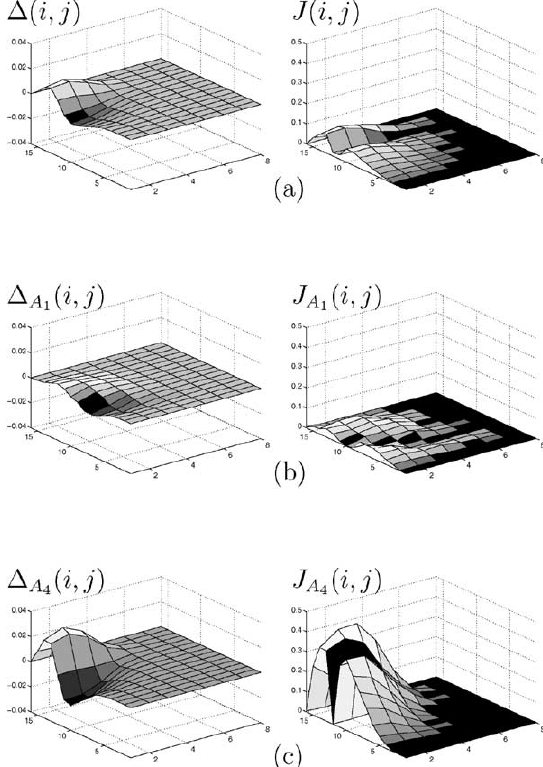
Fig. 6. Gray Level Run Length Matrix (GLRLM) Mahalanobis class distance matrices J ( i , j ) and GLRLM class difference matri- ces ∆ ( i , j ) between the two prognostic classes of early ovarian can- cer, computed from nuclear images with non-standardized first-order gray level statistics. The matrices were computed from (a) all 37,690 nuclei, (b) all nuclei within area interval A 1 (1000 (cid:1) nuclear area < 2000 pixels) and (c) all nuclei within area interval A 4 (4000 (cid:1) nuclear area < 5000 pixels). The positive (negative) values in the difference matrices correspond to GLRLM matrix elements that are more (less) probable for the good prognosis class compared to the poor prognosis class. The matrices were computed from the 70% central part of the nuclei.